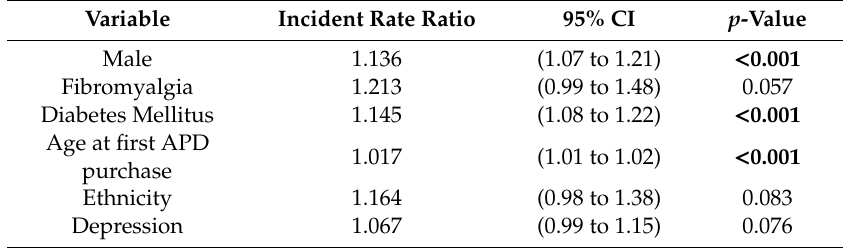
Table 3. Negative binomial model for number of di ff erent APDs every patient used adjusted to the time of